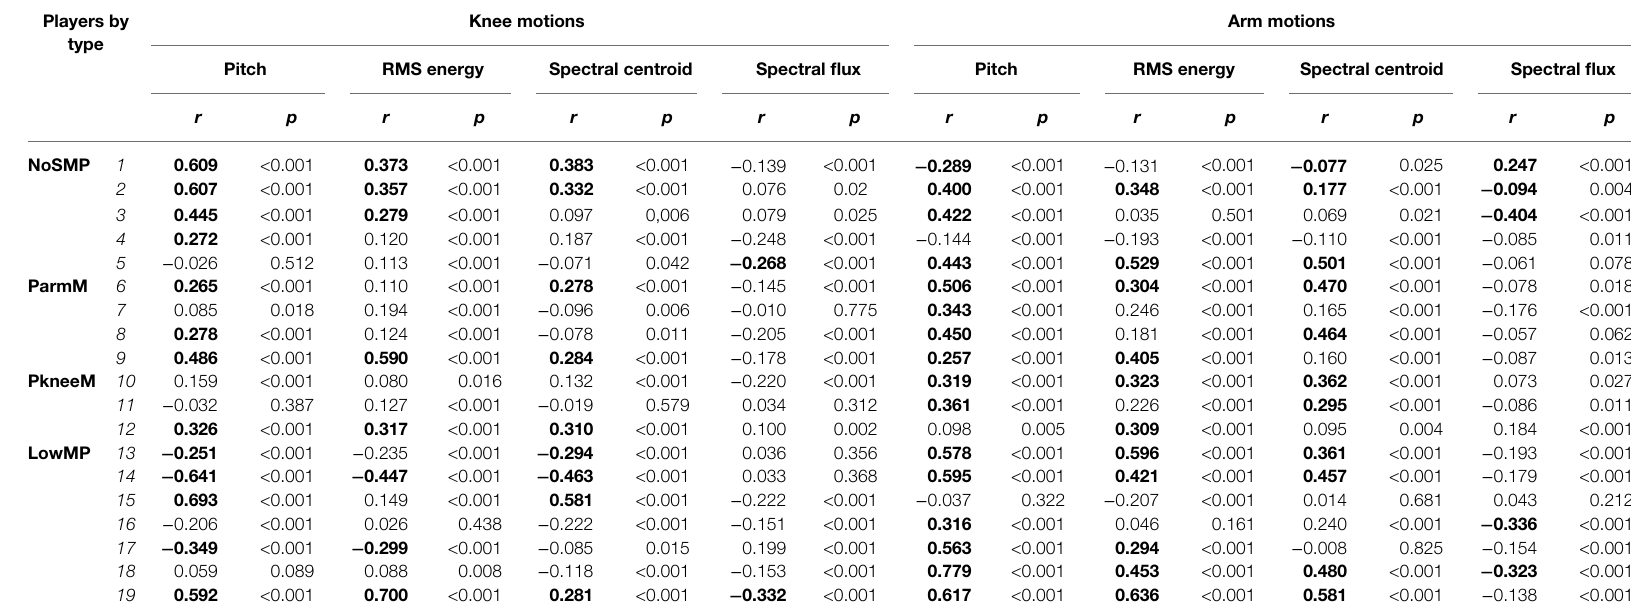
TABLE 2 | Correlation coefficients with significances between the movement trajectories in the motion areas and the acoustic parameters for each player (in bold: r > 0.25 or r < − 0.25). Players by type